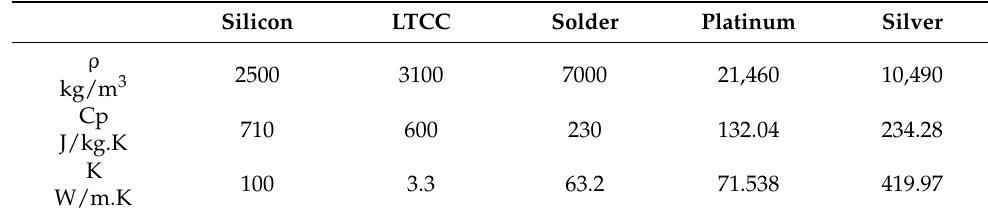
Table 1. Material properties for solid